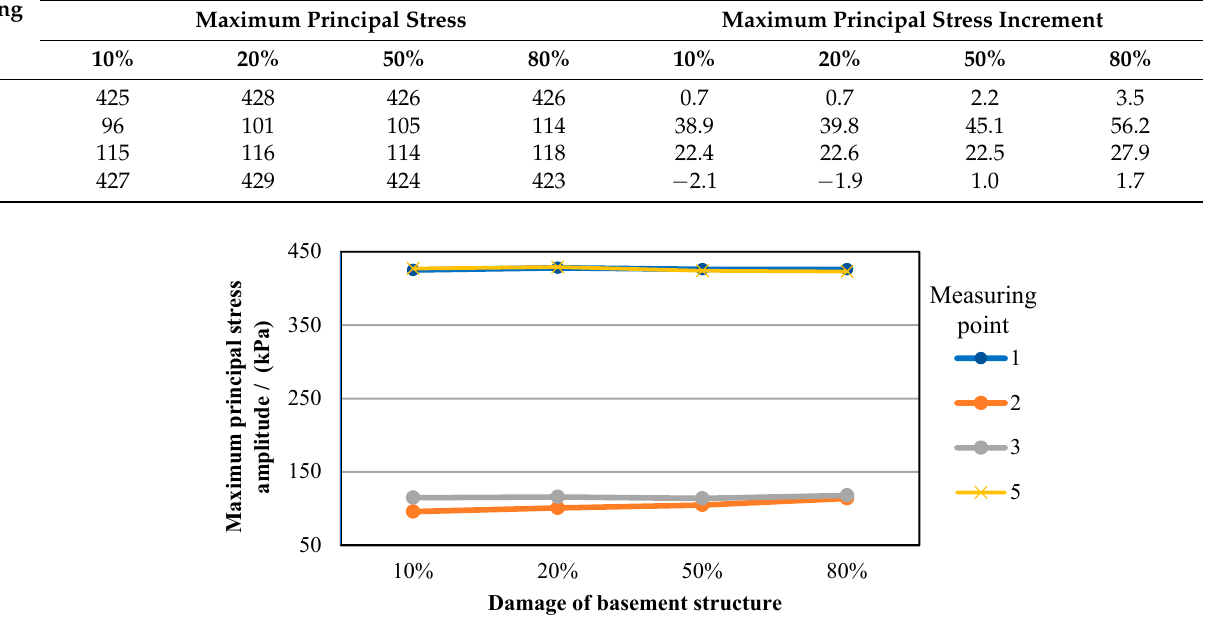
Figure 20. Maximum principal stress amplitude diagram of measuring points 1, 2, 3, and 5 under different degrees of damage to the basement structure.